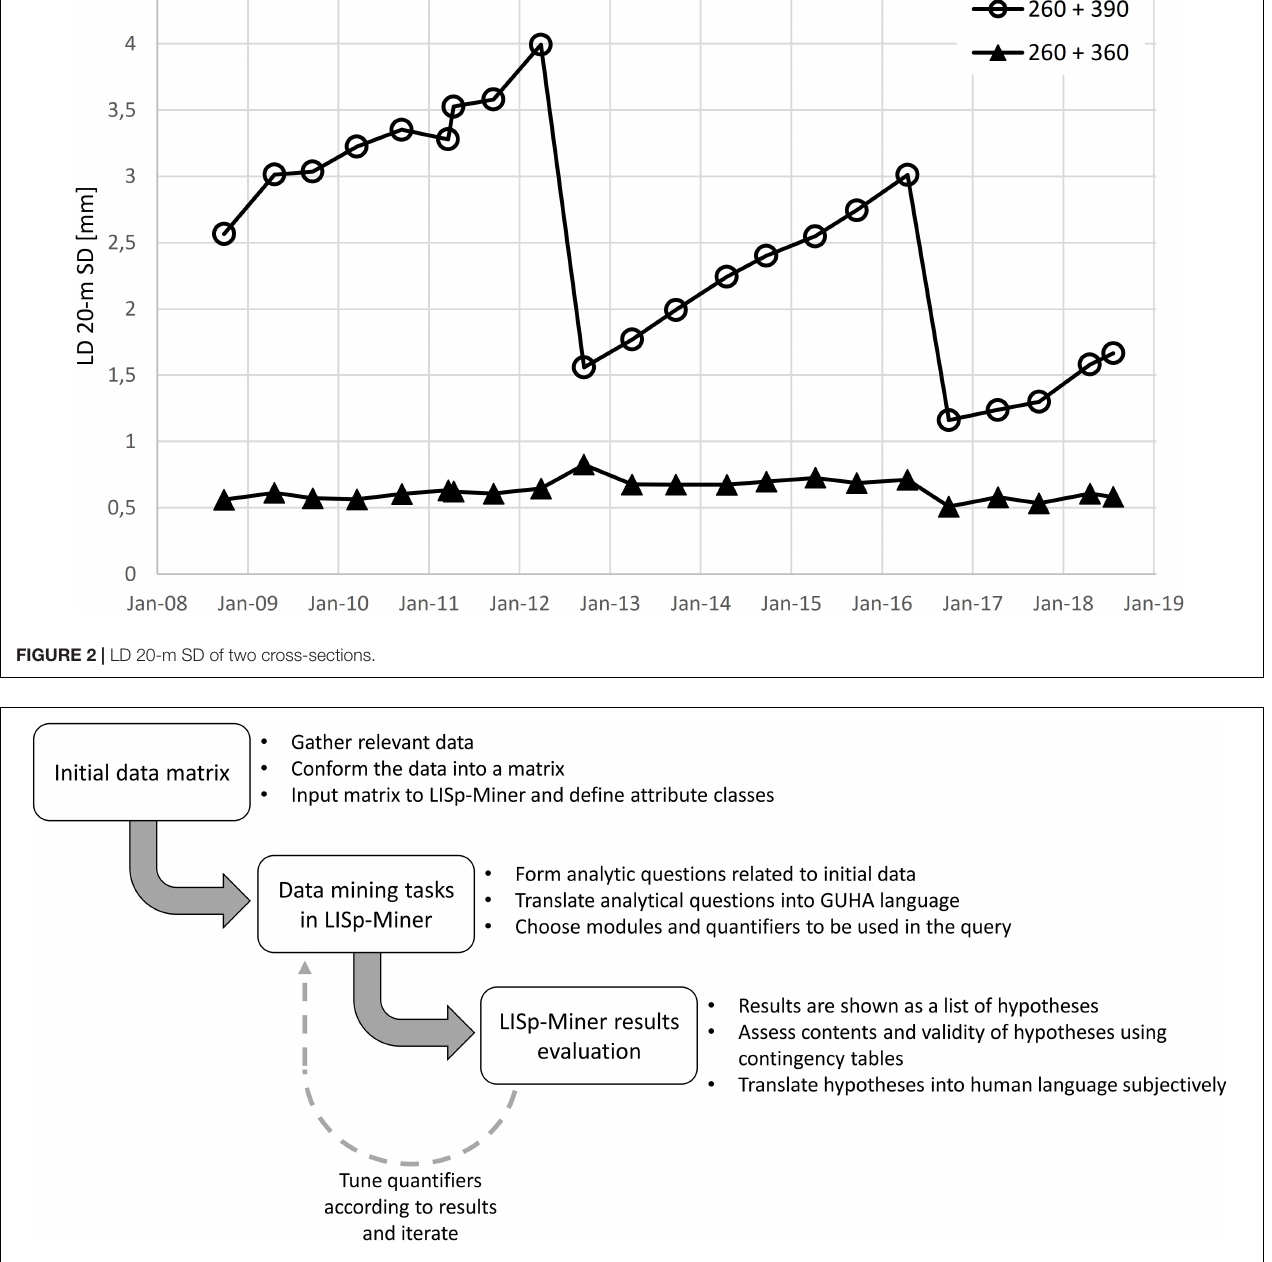
FIGURE 3 | Principle of the data mining process using